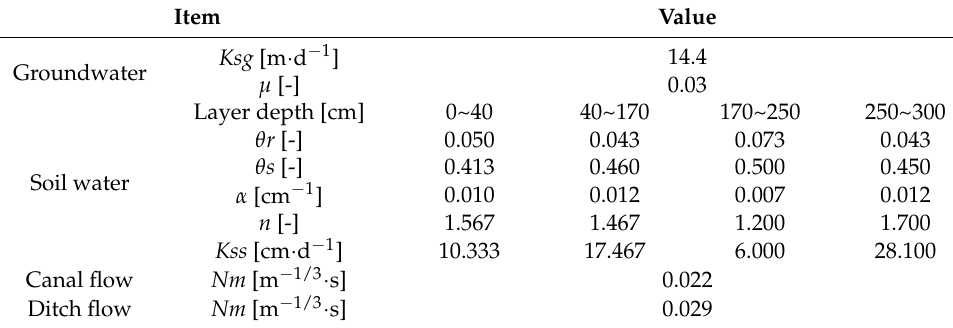
Table 1. Calibrated hydraulic parameters.